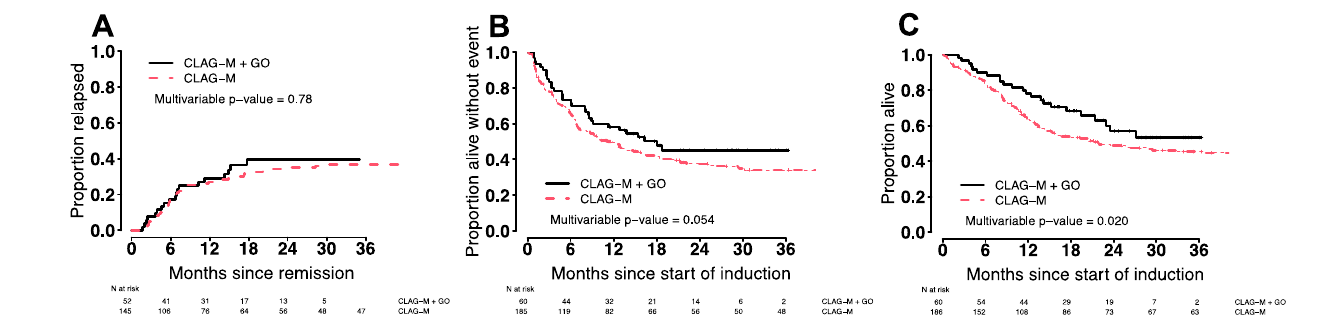
Figure 2. Estimates of ( A ) cumulative incidence of relapse, ( B ) event-free survival, and ( C ) overall survival for the 60 patients who received CLAG-M/GO3 and 186 medically matched patients who received CLAG-M without GO.